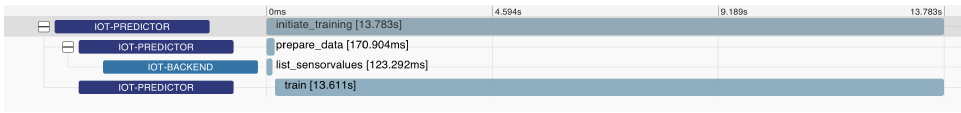
Figure 8. Trace 2 analysis in